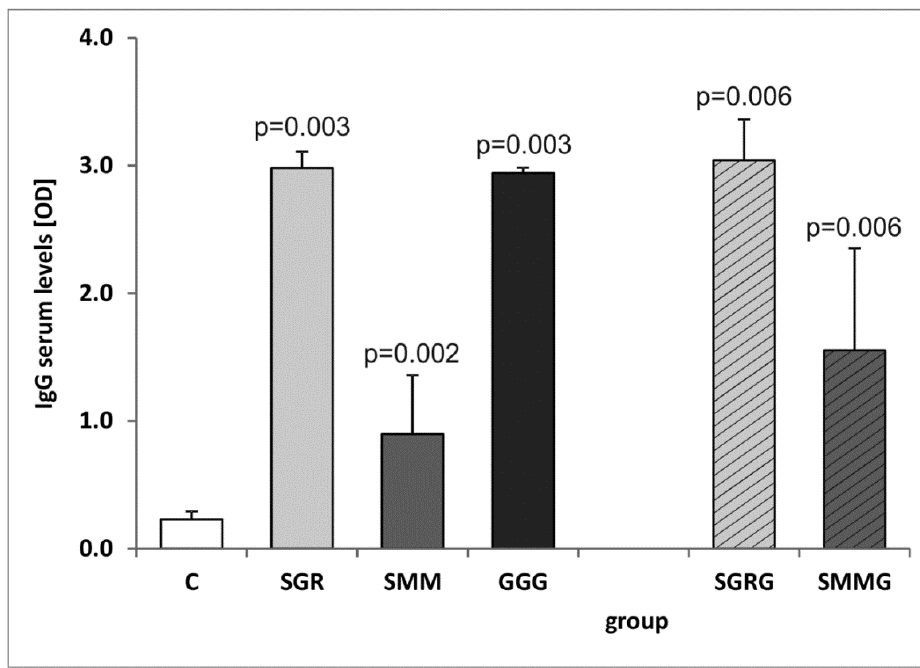
Figure 4. Reactivity of specific IgG antibodies from murine control and immune sera with Toxoplasma gondii antigen (TLA). p -values for statistically significant differences in reactivity of sera from immunized mice compared to control non-immunized group (C) are given above bars. Table 2. Titers of IgG1 and IgG2a antibodies in the sera of vaccinated mice. Trivalent Chimeric Proteins Tetravalent Chimeric